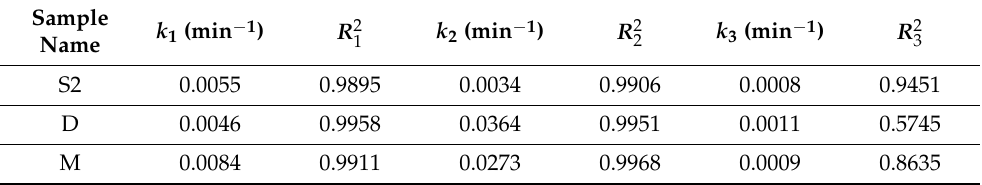
Table 3. Reaction kinetic constants of the S2, D, and M samples dispersed in the RhB aqueous solutions.